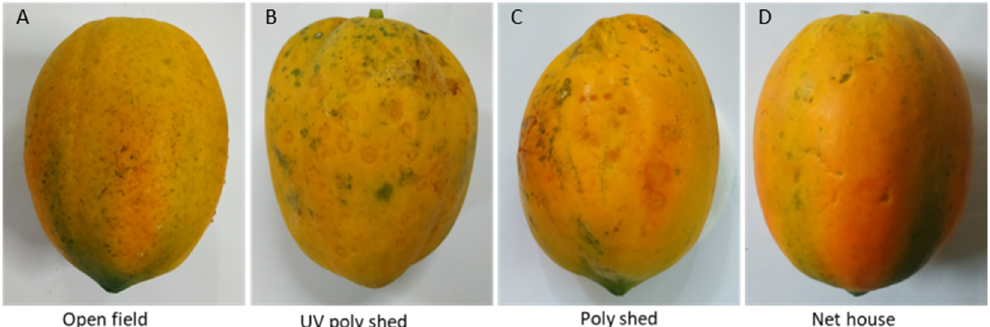
Figure 8. Skin color of papaya fruits grown under different shed houses ( A : Open field; B : UV poly shed; C : Poly shed; D : Net house ) .